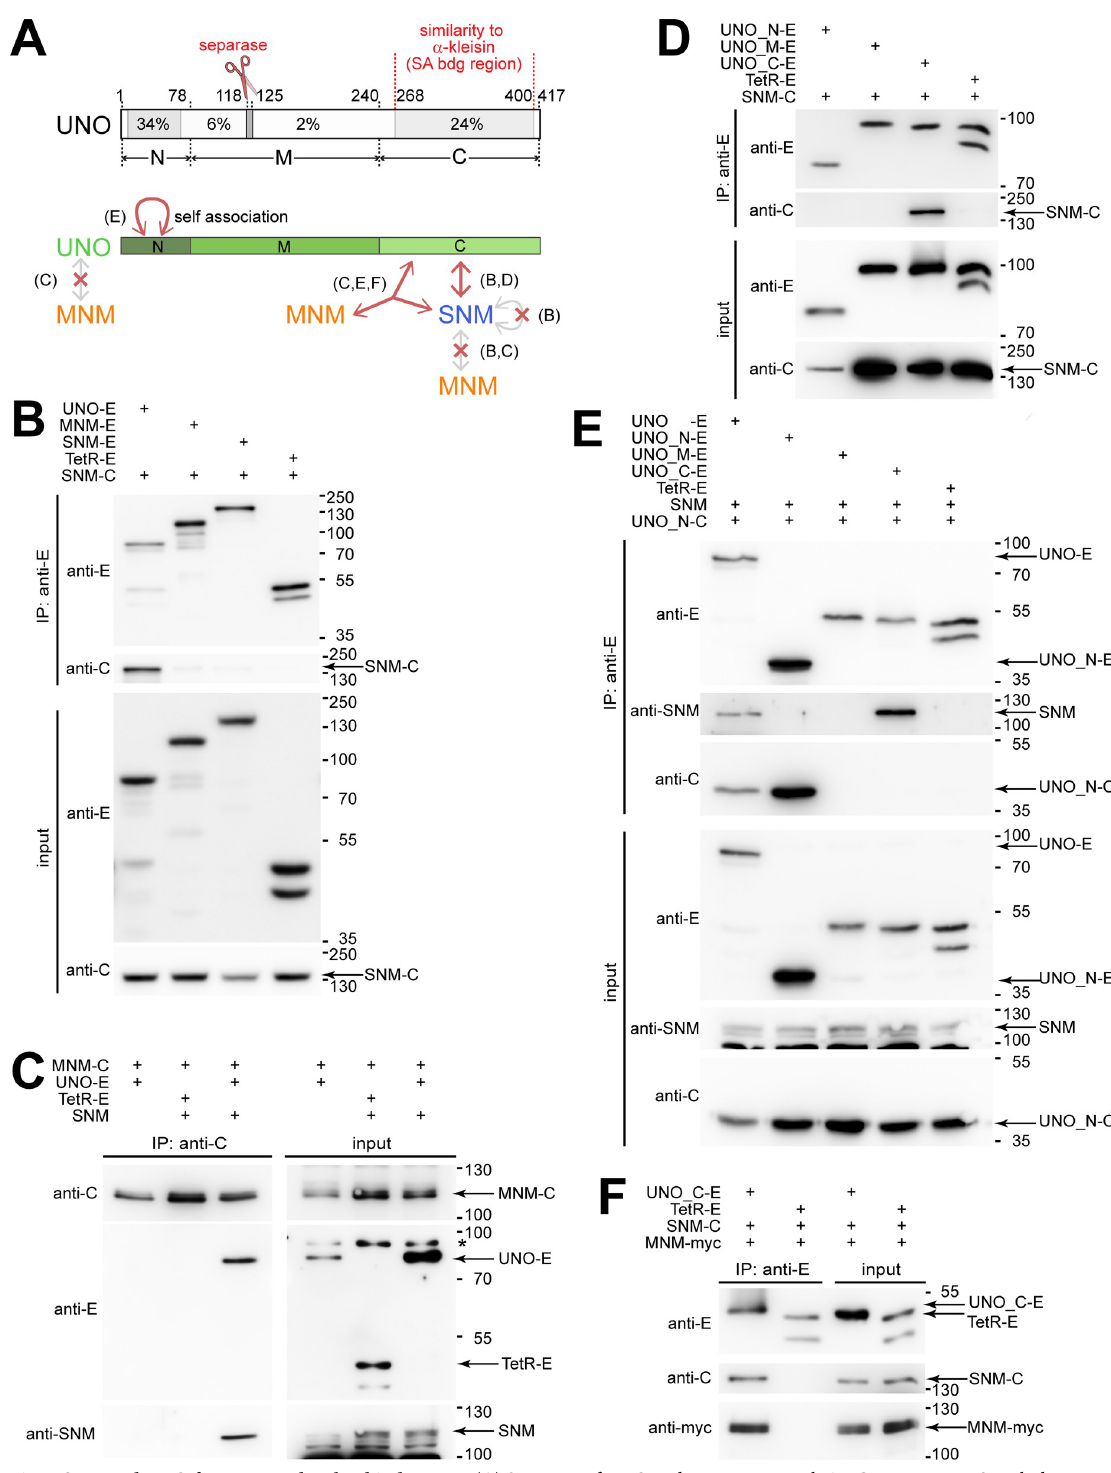
Fig 1. SNM and UNO form a complex that binds MNM. ( A ) Structure of UNO and interactions with AHC proteins. UNO includes two regions with stronger sequence conservation close to the N- and C-termini, as well as a highly conserved match to the separase cleavage-site consensus. Regional extent of amino acid identity (%) among drosophilid UNO orthologs is indicated with grey shading. Protein interactions of SNM, MNM and full-length UNO, as well as the UNO fragments UNO_N, UNO_M and UNO_C were analyzed by